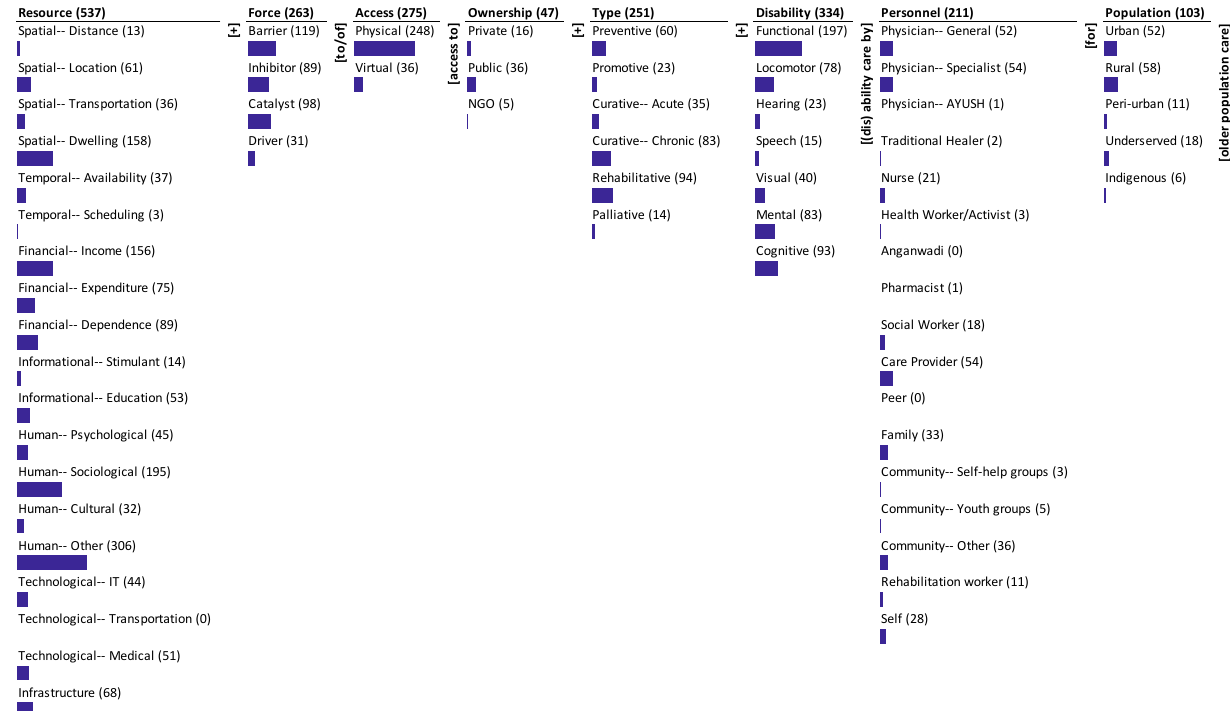
Figure 3. Monad map of access to geriatric disability care.